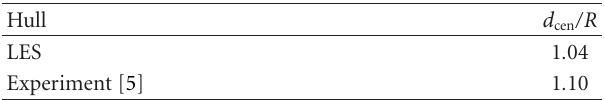
Table 4: Distance of the center of the vortex ring relative to the propulsor center with hull at J = − 1 .